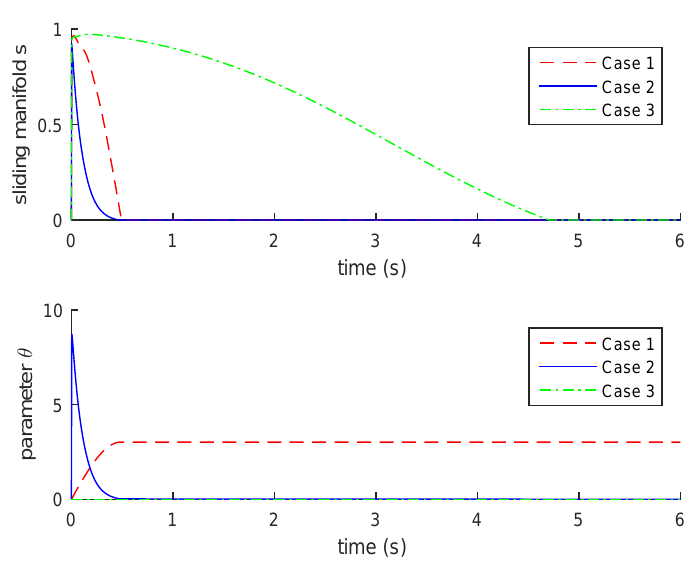
Figure 4. Sliding manifolds in Example